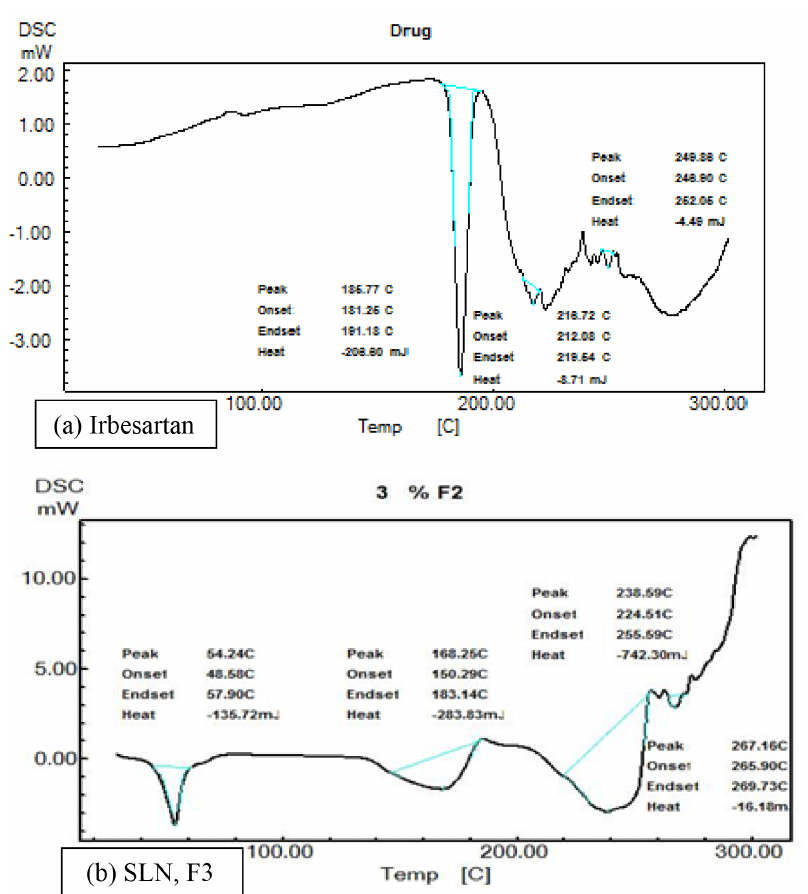
FIGURE 4 - DSC thermograms of (a) pure drug, Irbesartan and (b) Irbesartan-loaded SLN F3.